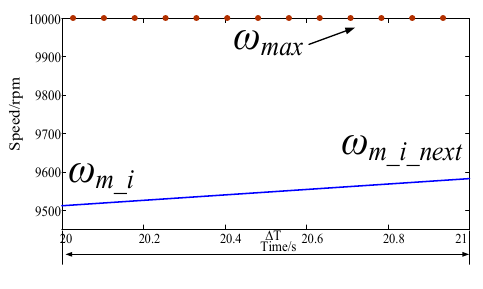
Figure 7. Prevention of overcharging.